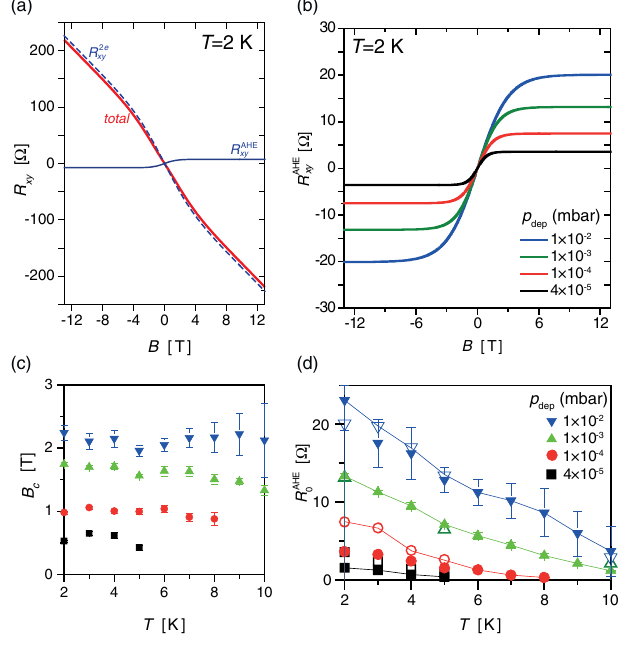
FIG. 8. (a) Separation of conventional 2 e contribution, R 2 e xy (dashed line), and the AHE contribution R AHE xy (solid line), obtained from fitting (solid red line) the total Hall resistance R R xy (respectively, the Hall coefficient H ) at 2 K for the sample 1 × 10 − 4 mbar. (b) Comparison of the AHE grown at p dep ¼ contribution obtained for different deposition pressure. (c) Critical field B c for saturation of the AHE contribution as a function of temperature. (d) Saturation resistance, R AHE 0 ∝ M 0 , of the AHE contribution as a function of temperature and deposition pressure. The critical temperature T c is defined by R AHE 0 → 0 to within experimental